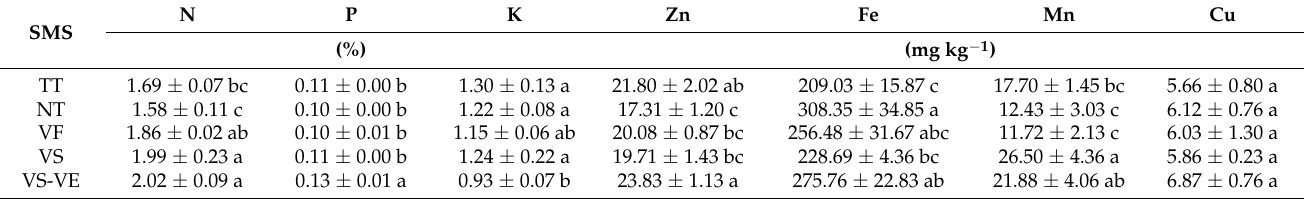
Table 5. Macro and micronutrient contents in almond leaf by different soil management